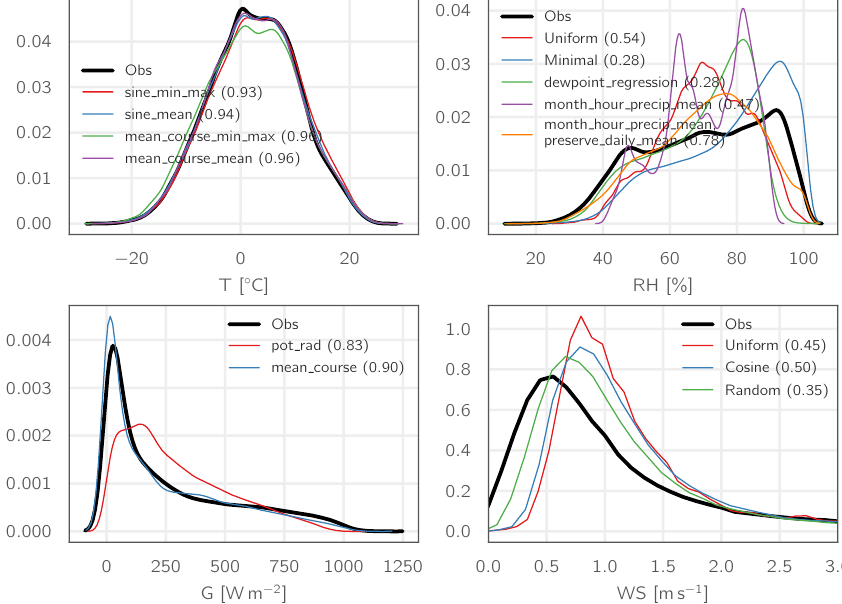
Figure 6. Density functions of the observed hourly values (black lines) for station Obergurgl (period 1999–2013) and the respective aggre- gated and disaggregated values using different disaggregation methods for the variables temperature, relative humidity, global radiation, and wind speed. Numbers in parentheses indicate the R 2 of the regression against the